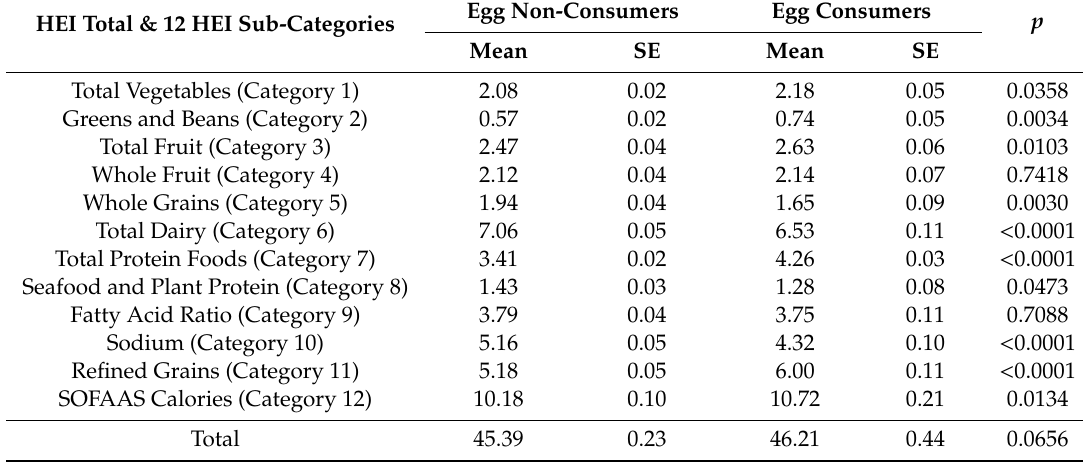
Table 3. Day 1 Healthy Eating Index-2010 (HEI) and Sub-Category Mean